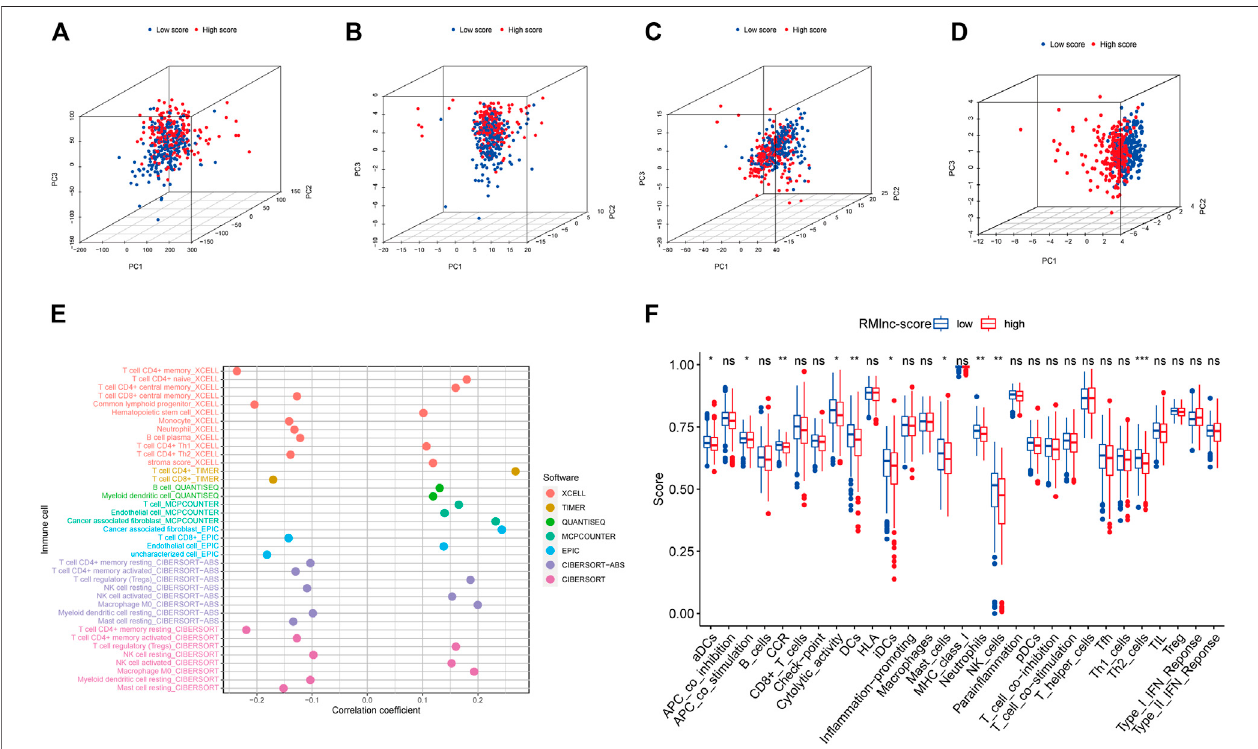
FIGURE 10 | The principal component analysis and immune microenvironment differences of high and low RMlnc-score groups. Principal component analysis betweenlowRMlnc-scoreand highRMlnc-scoregroupsbasedontheexpressionof (A) allgenes, (B) RNAmethylation-relatedgenes,and (C) RNAmethylation-related lncRNAsand the (D) seven lncRNAsofprognostic signature. (E) Correlation betweenRMlnc-scoreandtumor-in fi ltratingimmunecells. Thecorrelation coef fi cienthigher than 0 indicated positive correlation and lower than 0 denoted negative correlation. (F) Differences in immune cells and immune function between the high RMlnc- score and low RMlnc-score groups. *p < 0.05; **p < 0.01; ***p < 0.001; ns, no